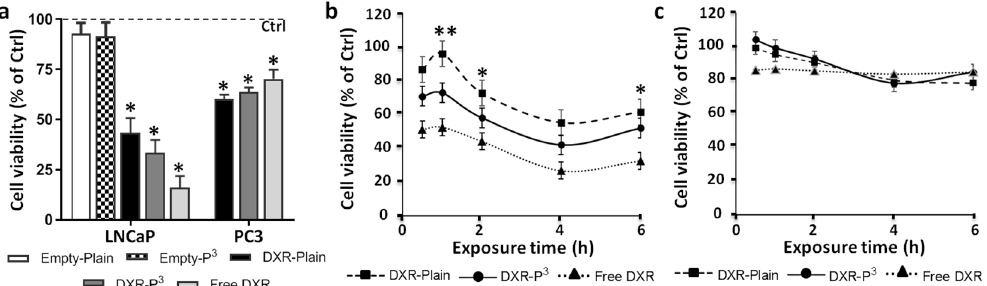
Figure 8. ( a ) Viability of LNCaP and PC3 cells after exposure to doxorubicin-Plain-liposome, doxorubicin-P 3 -liposomes, free doxorubicin, and empty liposomes for 24 h. ( b , c ) Viability vs. exposure time plots for LNCaP and PC3 cells, respectively, exposed to doxorubicin-Plain-liposome, doxorubicin-P 3 -liposomes, and free doxorubicin ((doxorubicin) = 1 µ M, * p < 0.05, ** p <